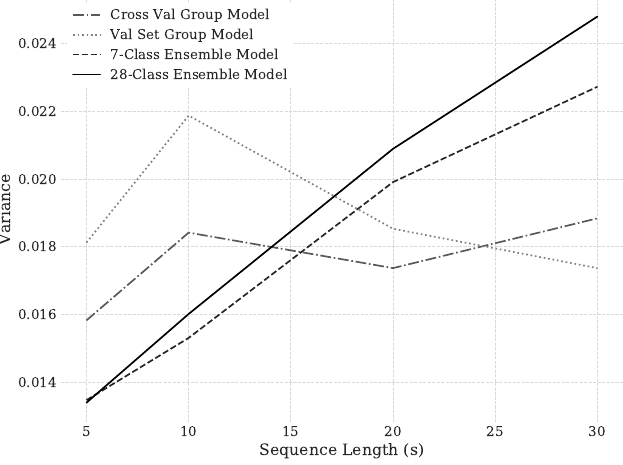
Figure 7. Interaction of sequence length and training method for cross-participant variance of